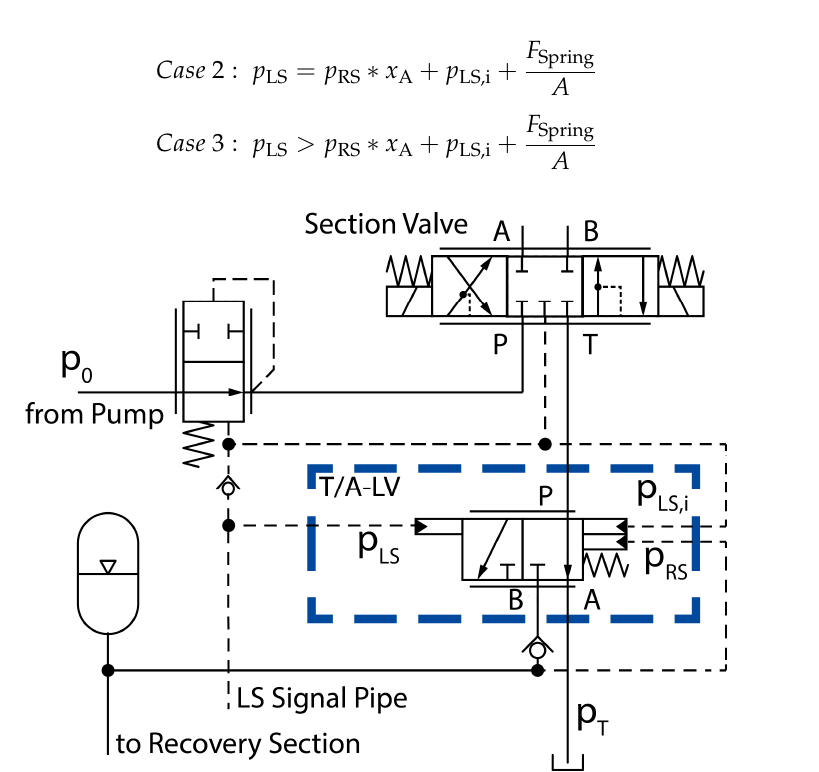
Figure 8. New circuit with T/A-LV in detail. Previously presented in [15]. Reproduced with permission from the publisher.